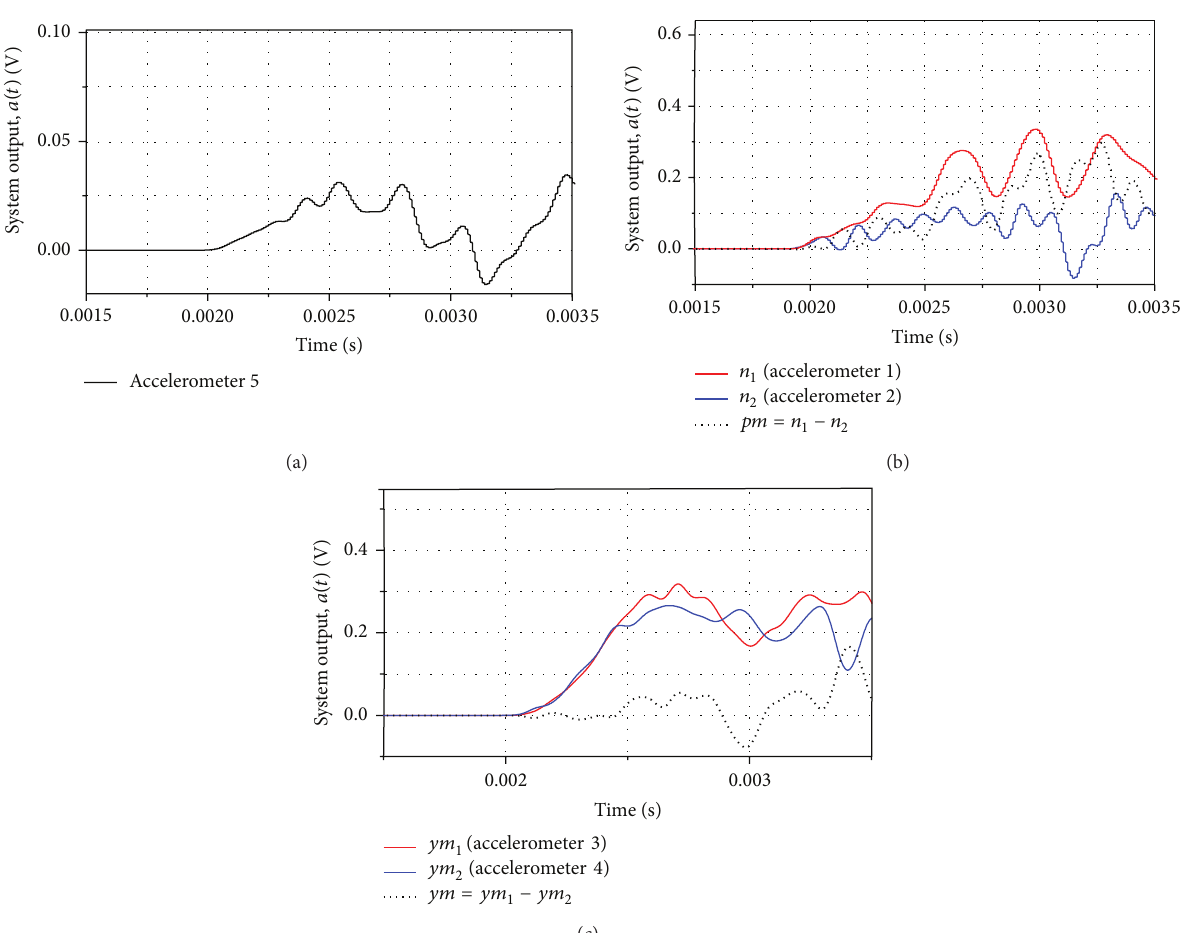
of such a system could be correlated using a convolution integral given by where 𝑎(𝑡) is the system output (Volt), 𝑔(𝑡) is the impulse response function, and 𝐹(𝑡) is the applied force (Newton), as depicted by the schematic of linear, time-invariant system in Figure 4.